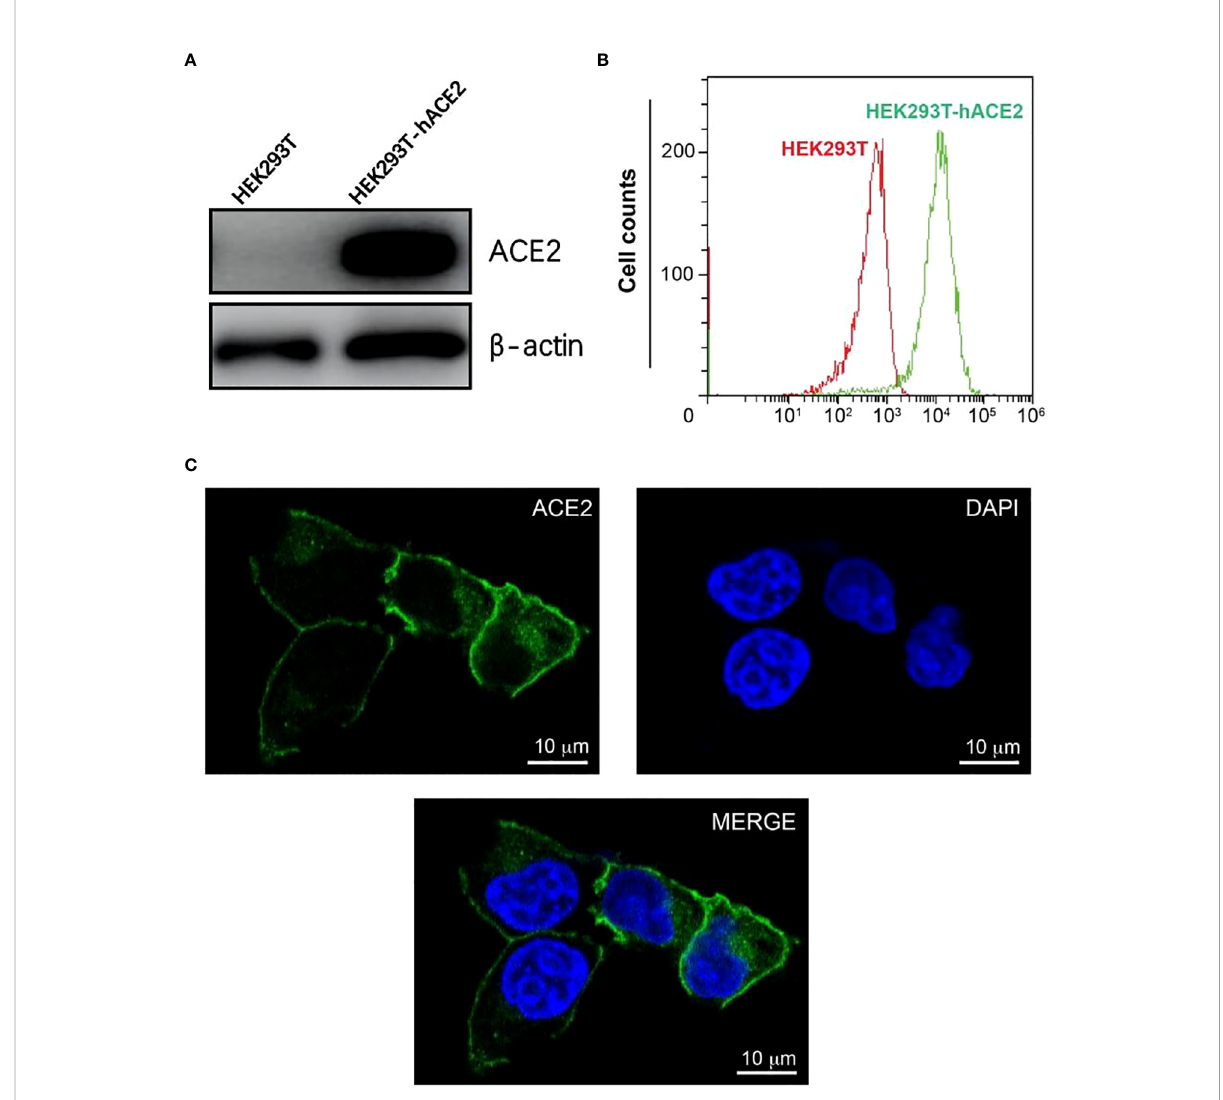
FIGURE 1 Construction and characterization of HEK293T-hACE2 cells. (A) Immunoblots show the expression of hACE2 in HEK293T-hACE2 cells but not HEK293T cells. b -actin was probed as a loading control. (B) Flow cytometry assays show the expression of hACE2 by the HEK293T-hACE2 cells compared to parental HEK293T cells after staining with an anti-hACE2 antibody. (C) Microscope images show the expression of human ACE2 in the HEK293T-hACE2 cells (DNA staining DAPI in blue, hACE2 antibody staining in green, scale bars 10